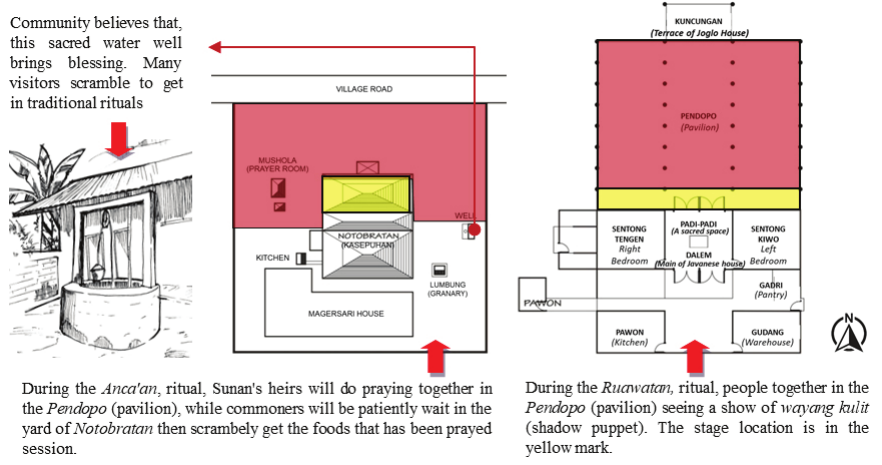
Figure 10. The using of space in traditional rituals of Sunan Kalijaga (source: Survey, 2017)